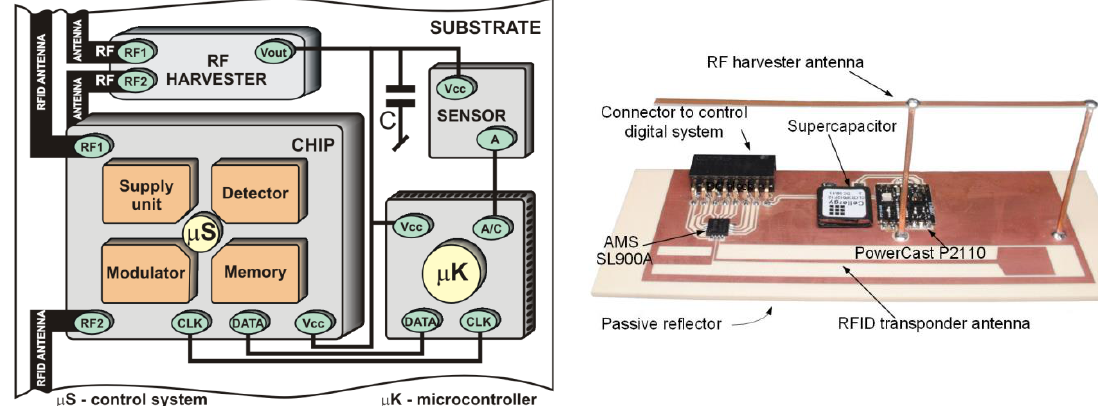
Figure 7. Autonomous RFID transponder: ( a ) Diagram of internal blocks; ( b ) Test model of